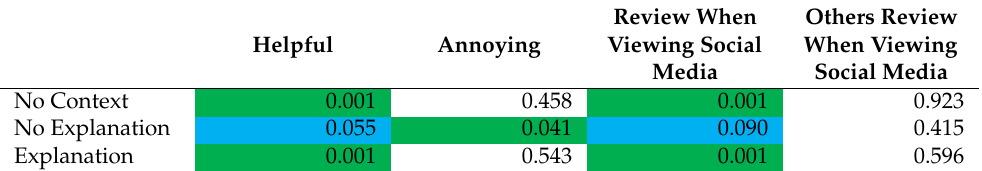
Table A8. Statistical significance calculations for university comparison data.